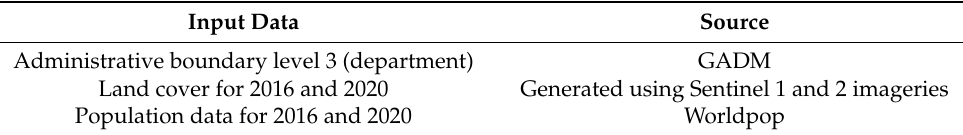
Table 5. Input data to measure land-consumption rate (SDG 11.3.1).